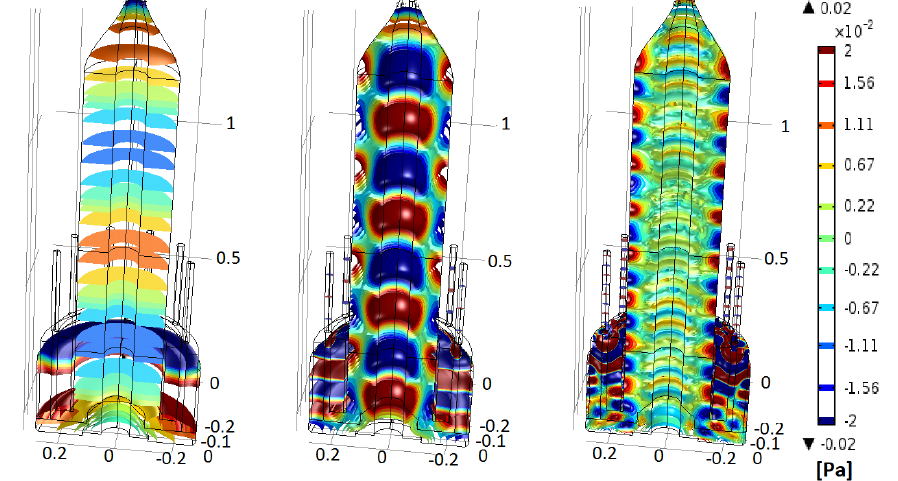
Figure 6. Acoustic pressure field isosurfaces in the secondary flow circuit at 480 Hz ( left ), 2050 Hz ( center ) and 4790 Hz ( right ). The scale enhances the modes visualization that otherwise would be very faint at full